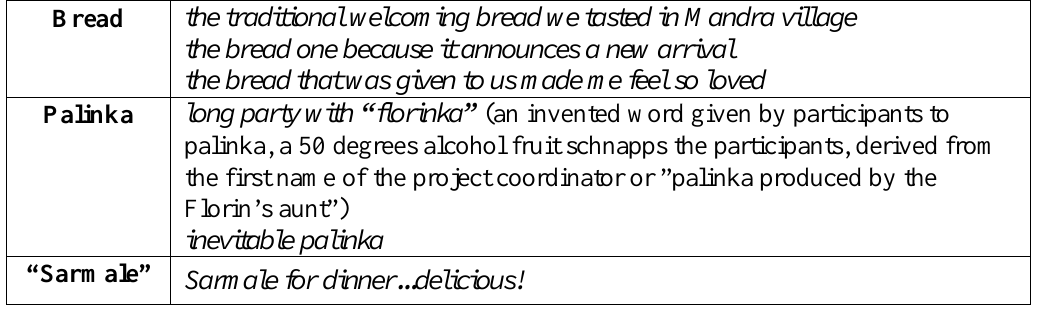
Table 5: Description Tastes associated with Italian Participants Experience